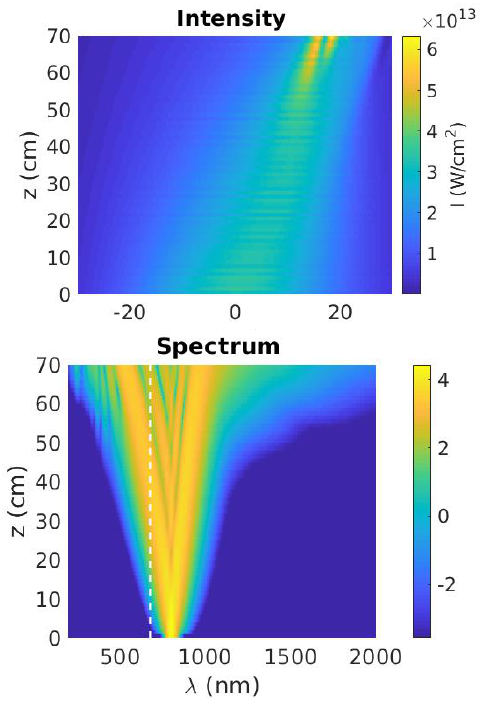
Fig. 4. Energy, FWHM and Fourier limit dependence with the pressure at 66